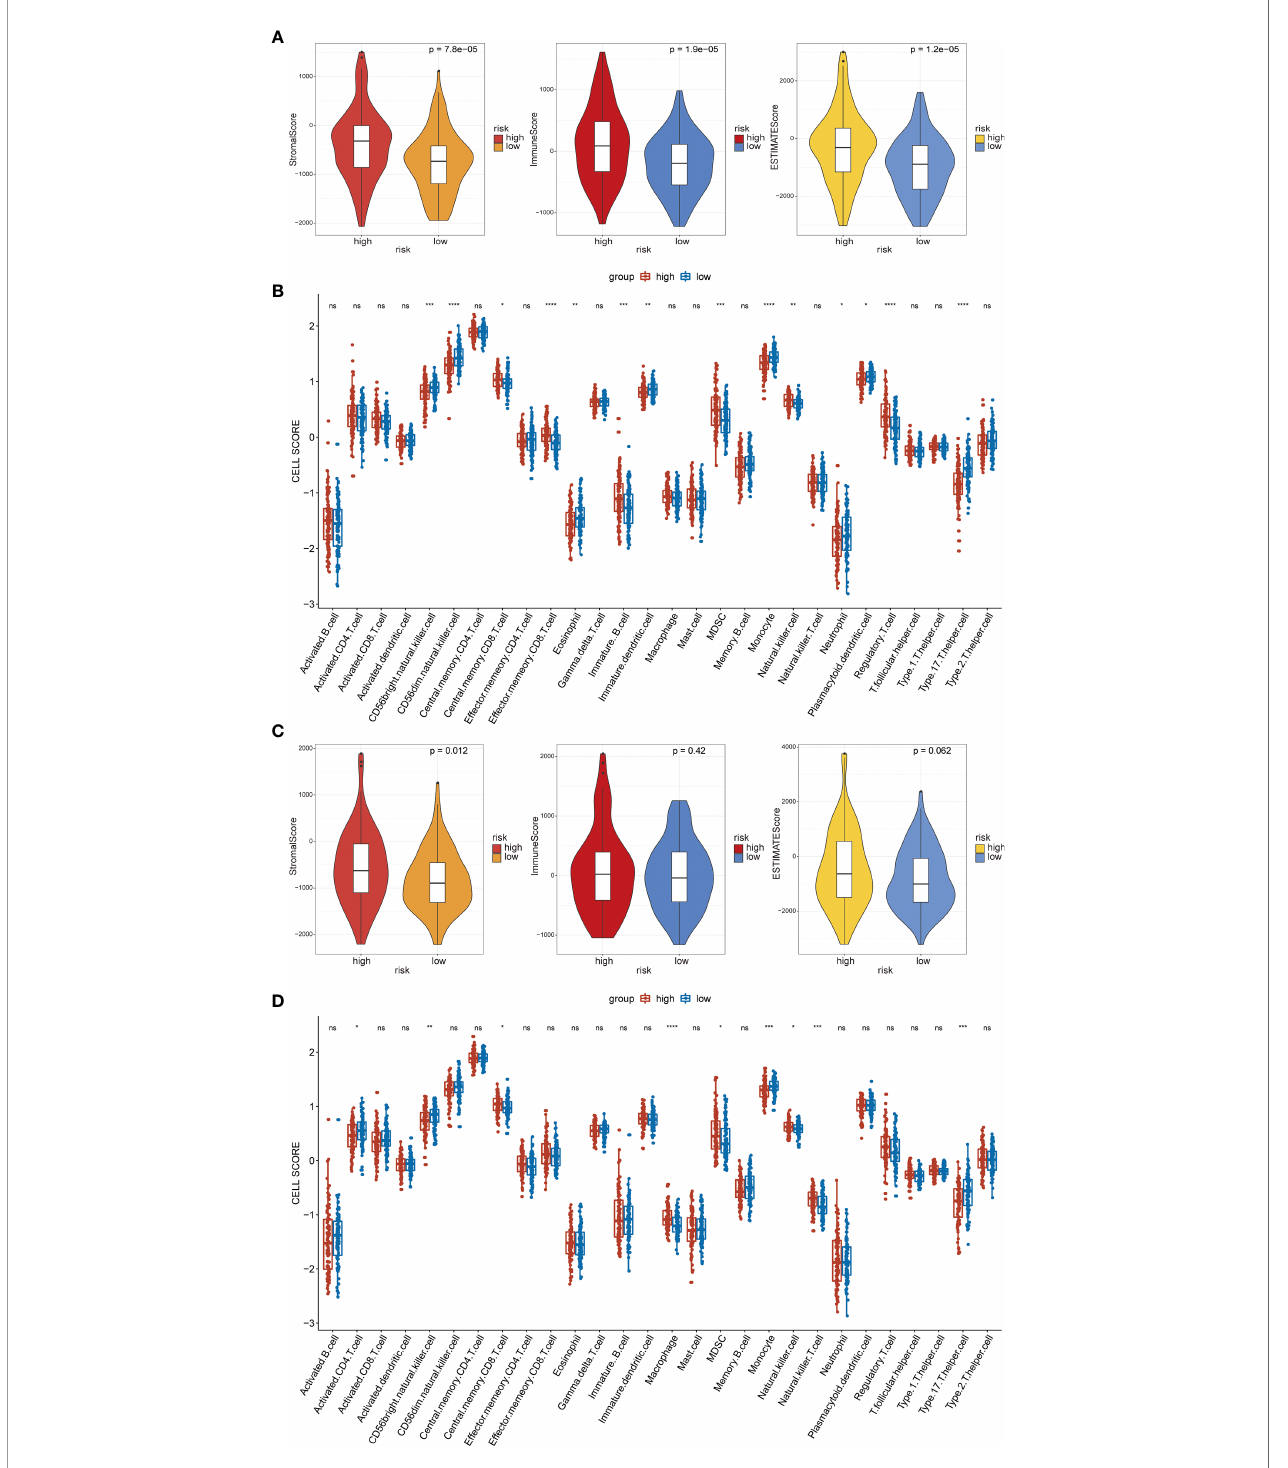
FIGURE 10 | Immune analysis of the high- and low-risk groups. (A) The distribution of stromal scores, immune scores, and ESTIMATE scores in high- and low-risk groups of LCRC, all the P < 0.05. (B) Boxplot showing the differential abundance of 28 in fi ltrative immune cells calculated by ssGSEA between high-and low-risk groups in the LCRC. (C) The violin plot shows a correlation between the high-/low-risk group of RCRC and the stromal/immune/ESTIMATE scores level. (D) Boxplot of the abundance of immune cells between risk groups in TCGA-RCRC samples. * p < 0.05, ** p < 0.01, *** p < 0.001, **** p < 0.0001. ns, not statistically signi fi